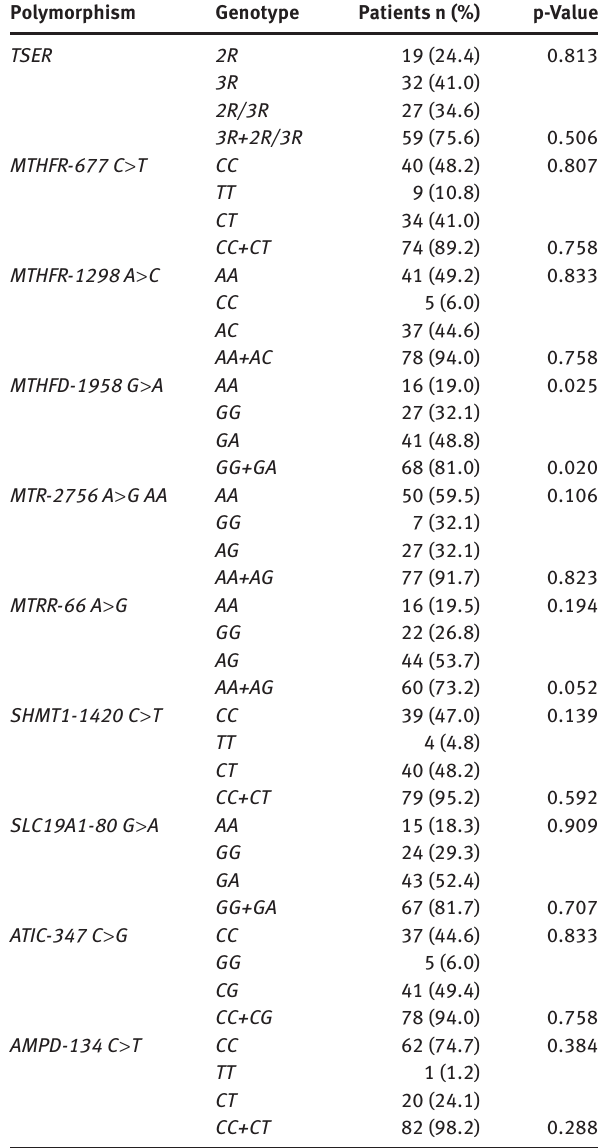
Table 4 Patients with clinical response by